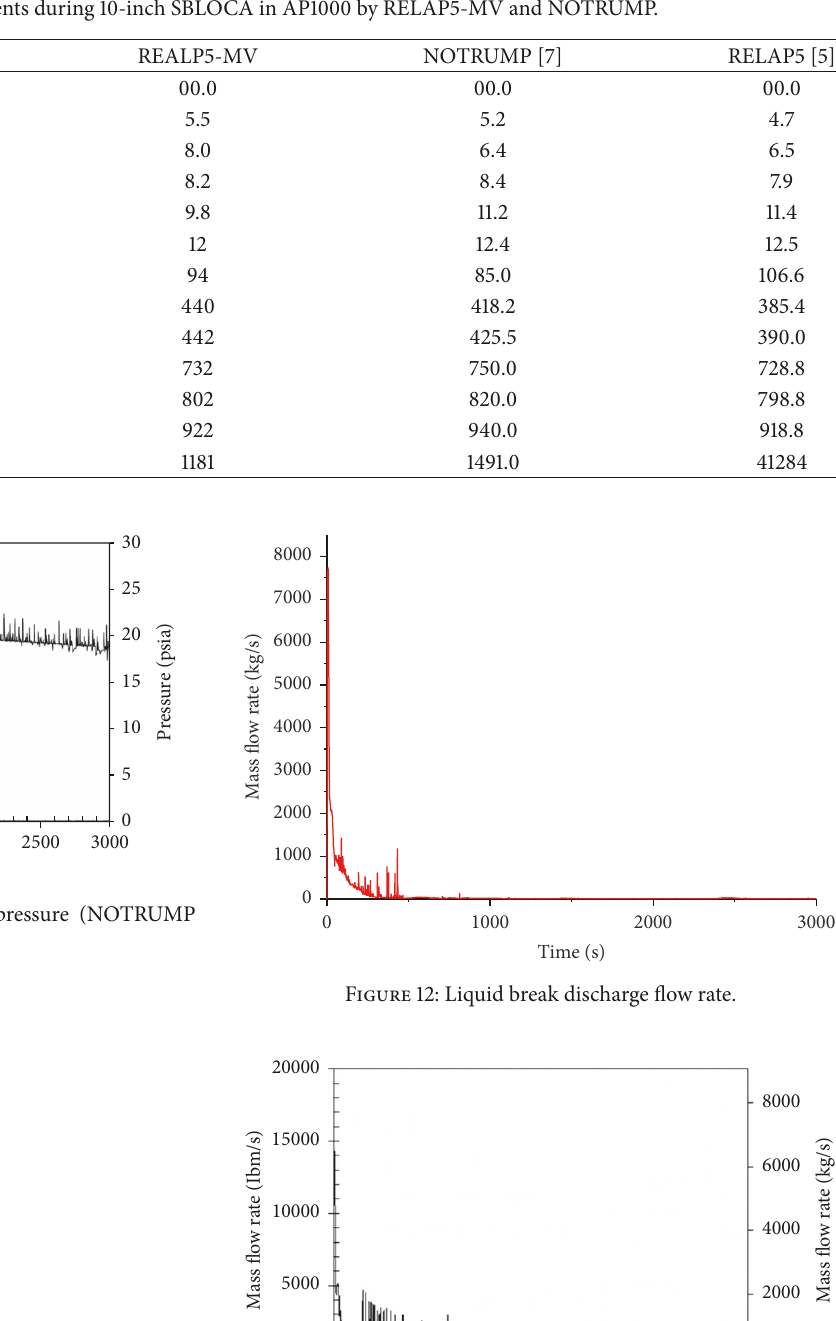
Table 3: Sequence of events during 10-inch SBLOCA in AP1000 by RELAP5-MV and NOTRUMP.